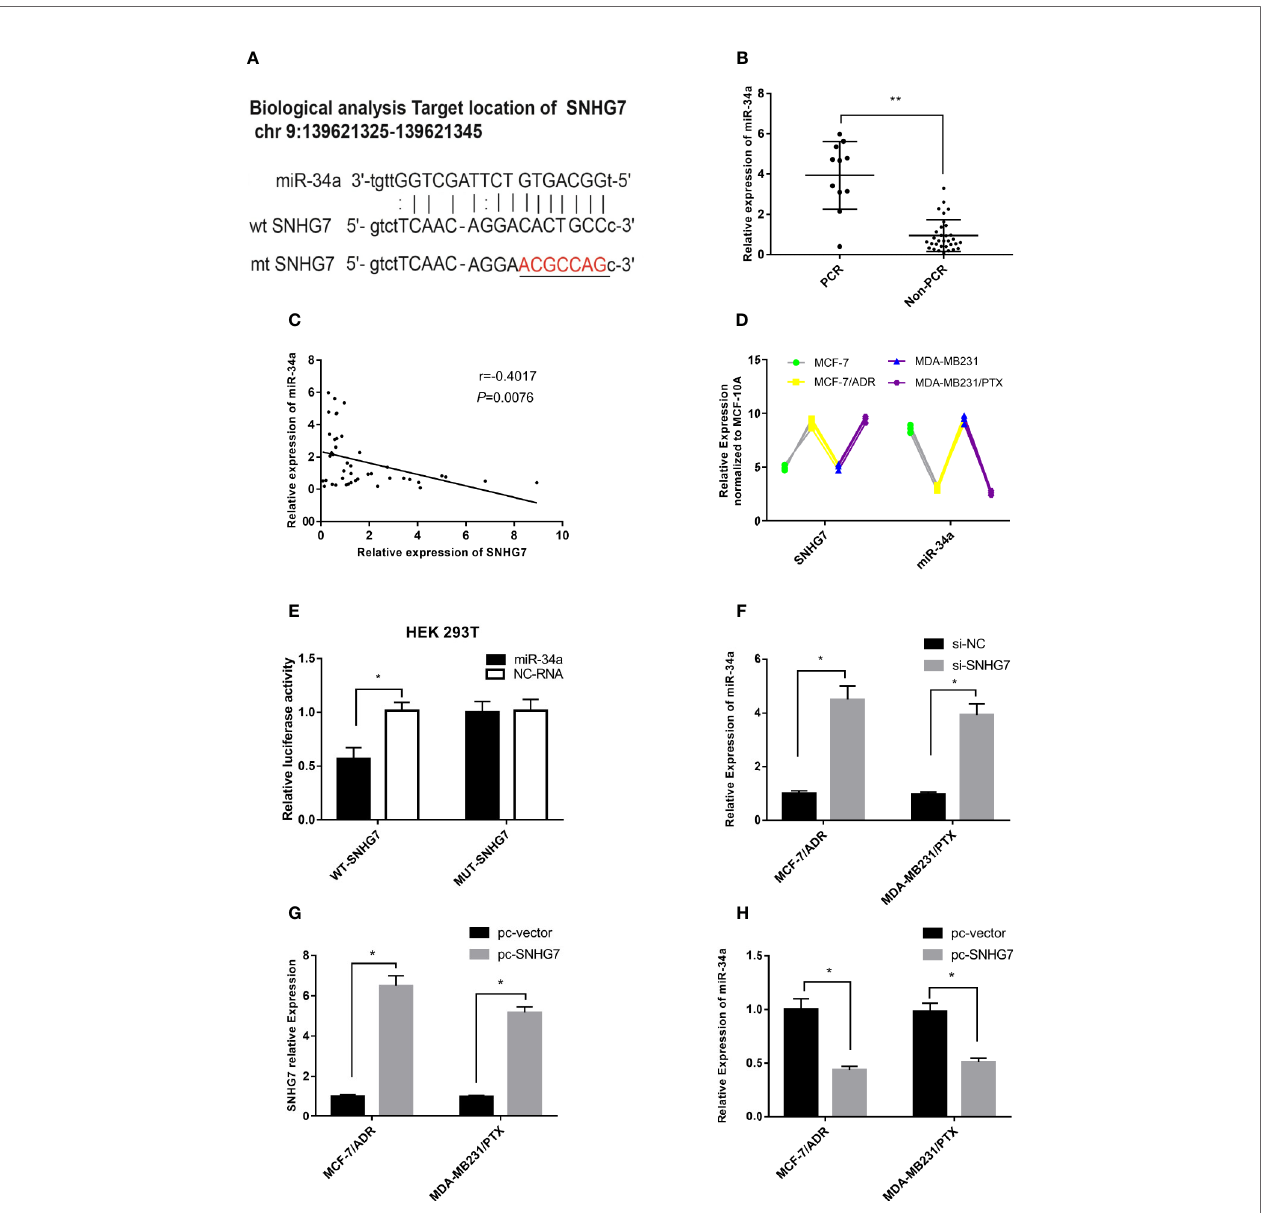
FIGURE 4 | SNHG7 sponged miR-34a in chemoresistant breast cancer cells. (A) Bioinformatics analysis predicted that SNHG7 harbored miR-34a binding sites. (B) miR-34a expression was associated with pCR of breast cancer after NAC. (C) miR-34a was negatively correlated with SNHG7 expression in breast cancer tissues. (D) Compared with the parental cells, the expression of SNHG7 in MCF-7/ADR and MDA-MB-231/PTX cells was increased, while the expression of miR-34a was decreased. (E) A luciferase activity assay was performed after co-transfection of HEK-293T cells with a reporter plasmid and miR-34a. (F) miR-34a expression increased after transfection with si-SNHG7 into MCF-7/ADR and MDA-MB-231/PTX cells. (G, H) After MCF-7/ADR cells were transfected with the pcDNA3.1-SNHG7plasmid, the expression of SNHG7 increased, whereas it markedly reduced miR-34a expression. *P < 0.05, **P < 0.01 represent a statistically signi fi cant